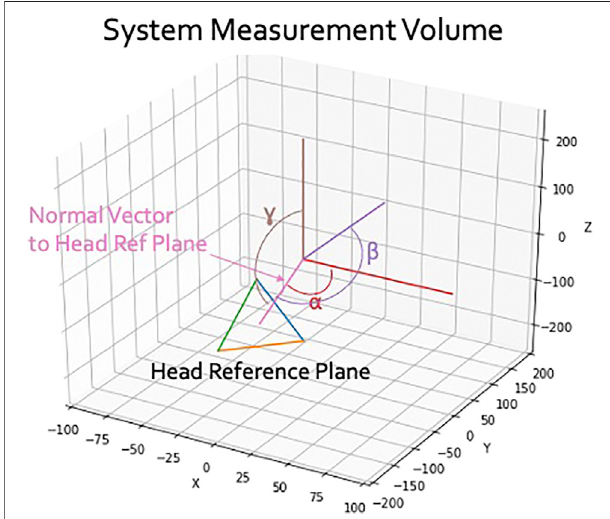
FIGURE 2 | Illustration of the head movement